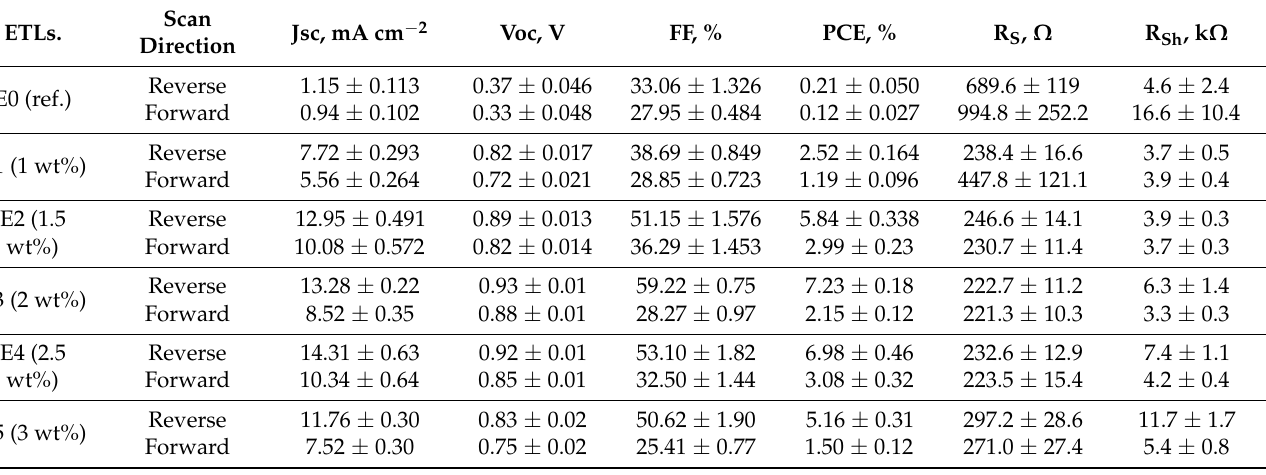
Table 1. Statistical analysis of the performance parameters of the top 40 well-performing devices for different ETLs.